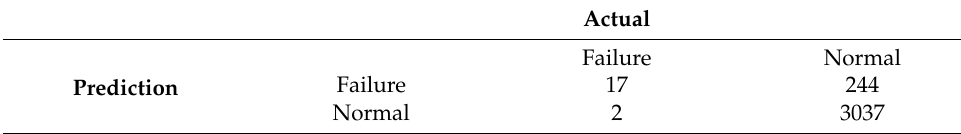
Table 7. Prediction results for the TWF diagnosis obtained using the confusion matrix.